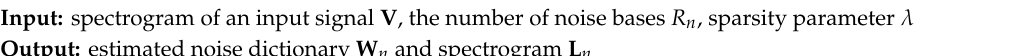
Algorithm 1. Noise dictionary learning by robust